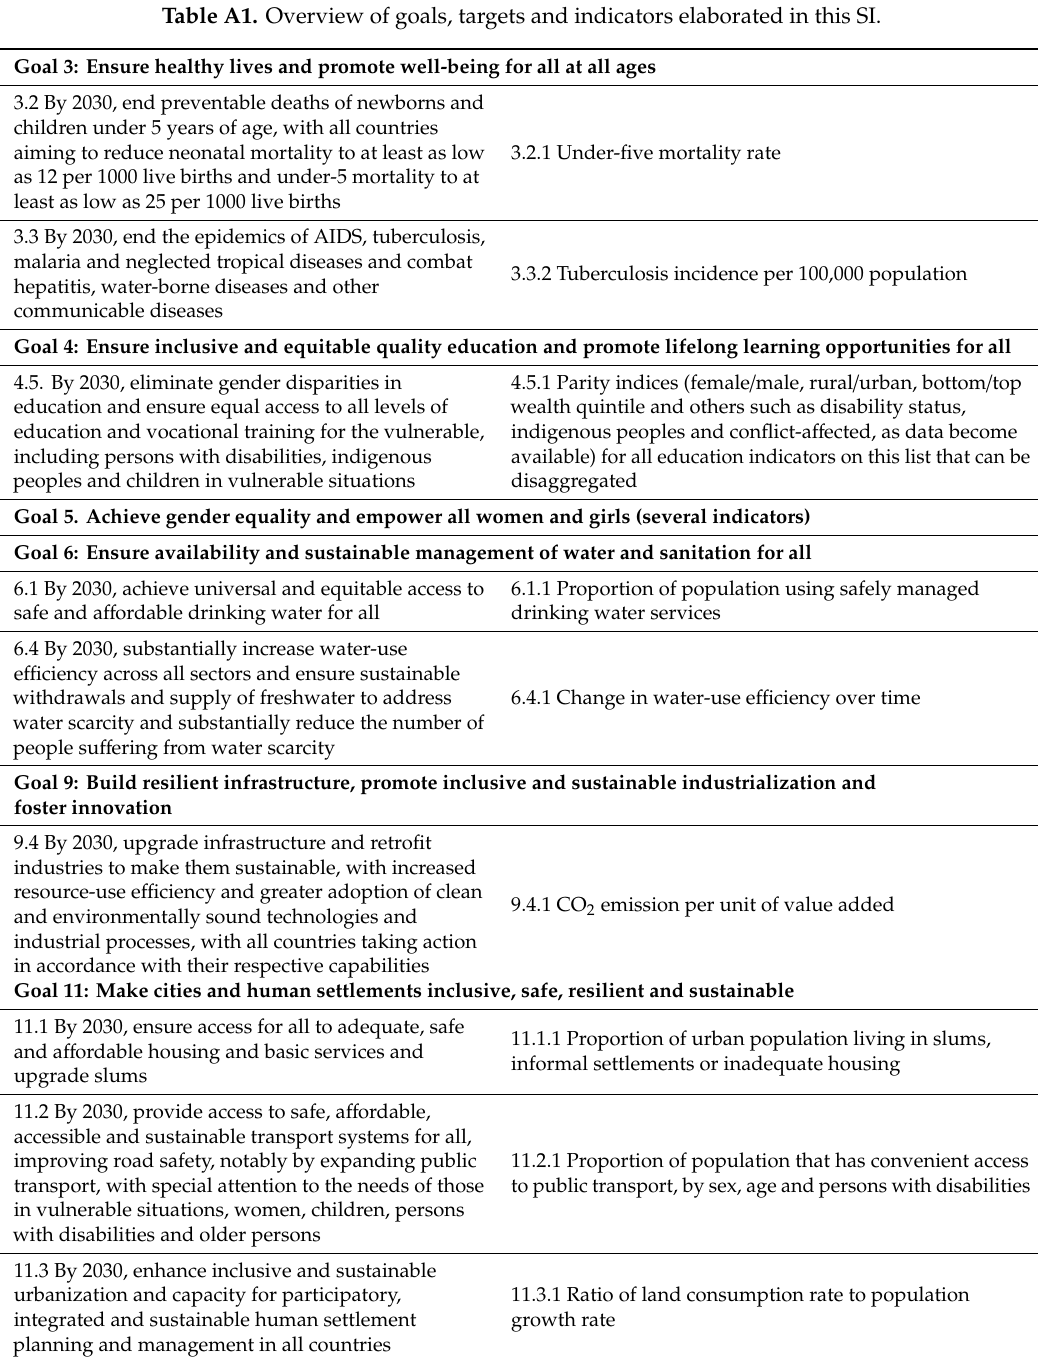
Table A1. Overview of goals, targets and indicators elaborated in this